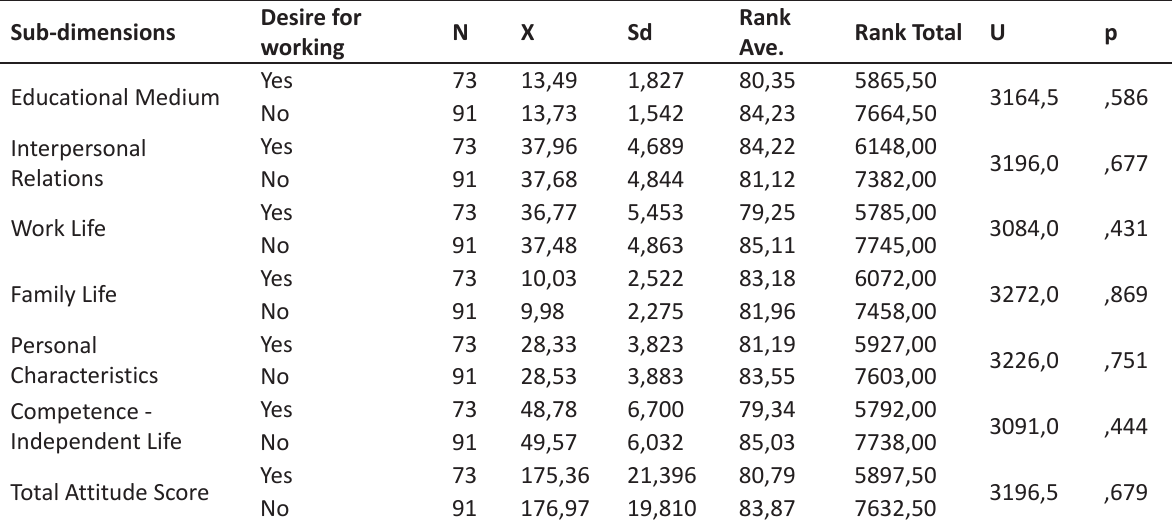
Table 10. Comparison of the Attitudes of the Participants towards the Handicapped according to the Desire to Work in a School that Provides Education on Special Education (the Handicapped) Desire for Sub-dimensions